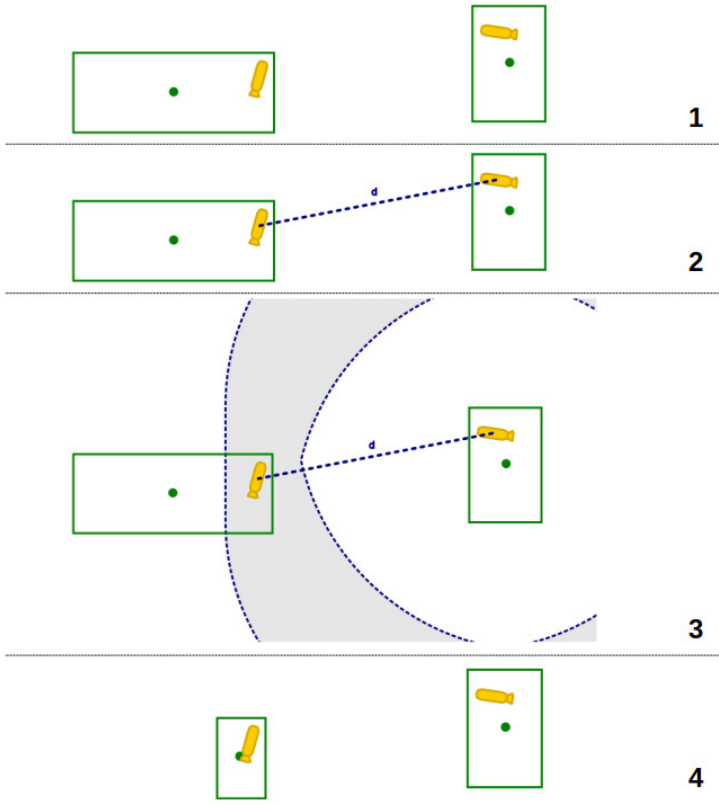
Figure 3. Localization accuracy procedure.